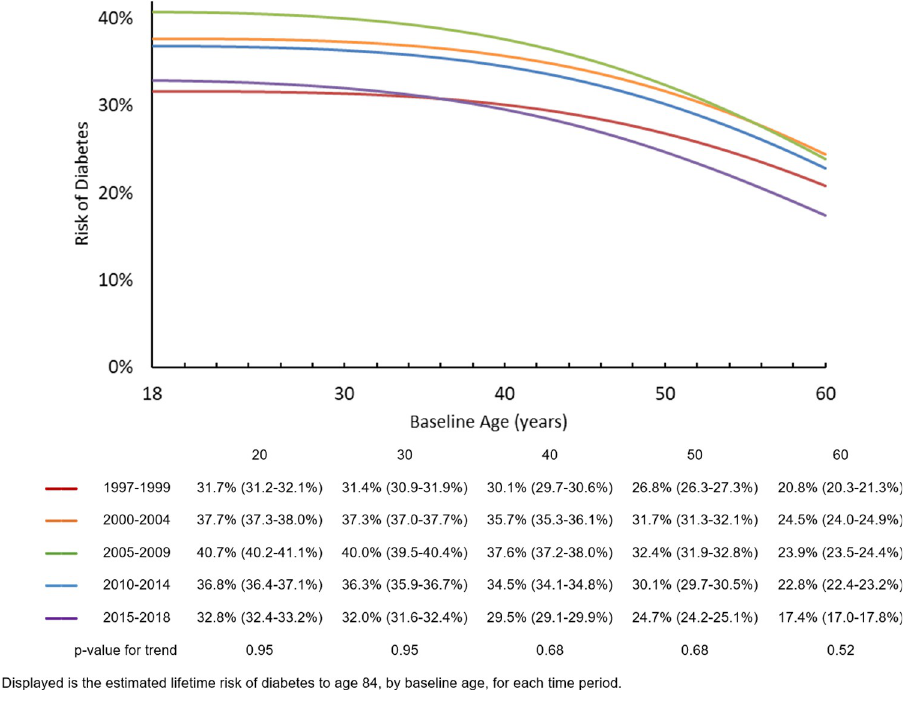
Fig 1. Lifetime risk of diabetes from age 18 to 84, by baseline age and time period.